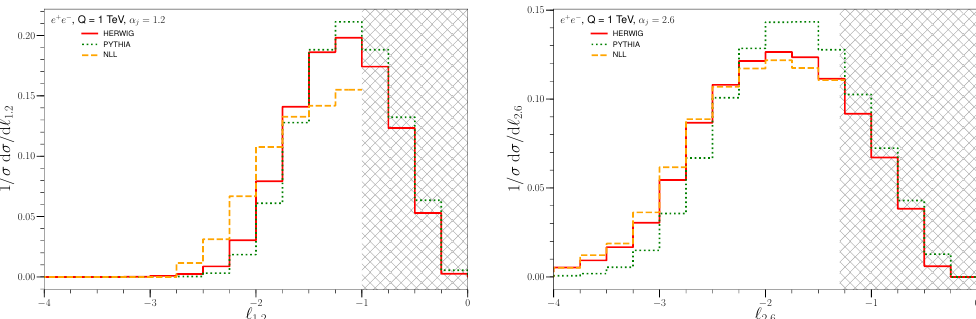
Figure 4 . The Herwig (red), Pythia (green dotted) and analytical NLL (yellow dashed) pre- dictions for the ‘ 1 : 2 and ‘ 2 : 6 distributions. The (cid:12)xed-order region has been grayed out and the analytical results have been normalised to the fraction of the area of the Herwig results that lies to the left of that region.